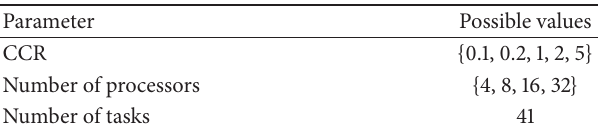
Table7:Configurationparametersforthemoleculardynamicscode